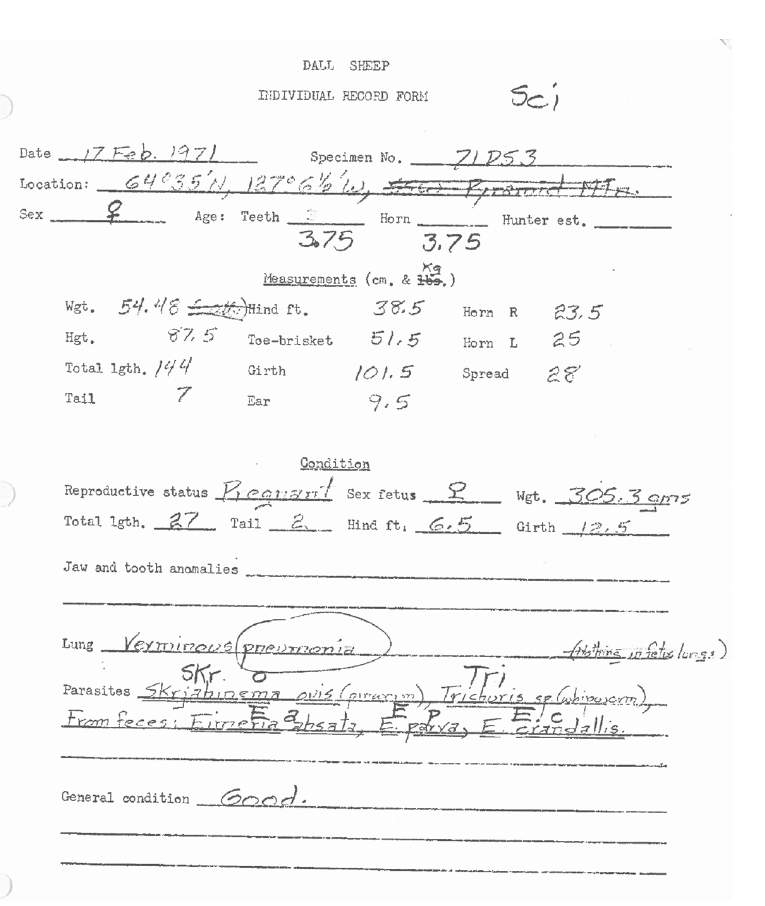
Fig 1. Original post mortem card. Card used by Dr. Norman Simmons to record the individual physiological and reproductive information of Dall’s sheep captured in the Mackenzie Mountains during February